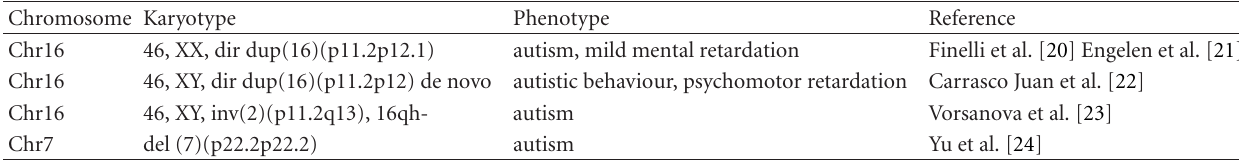
Table 2: Autism related breakpoints on 7p22p and